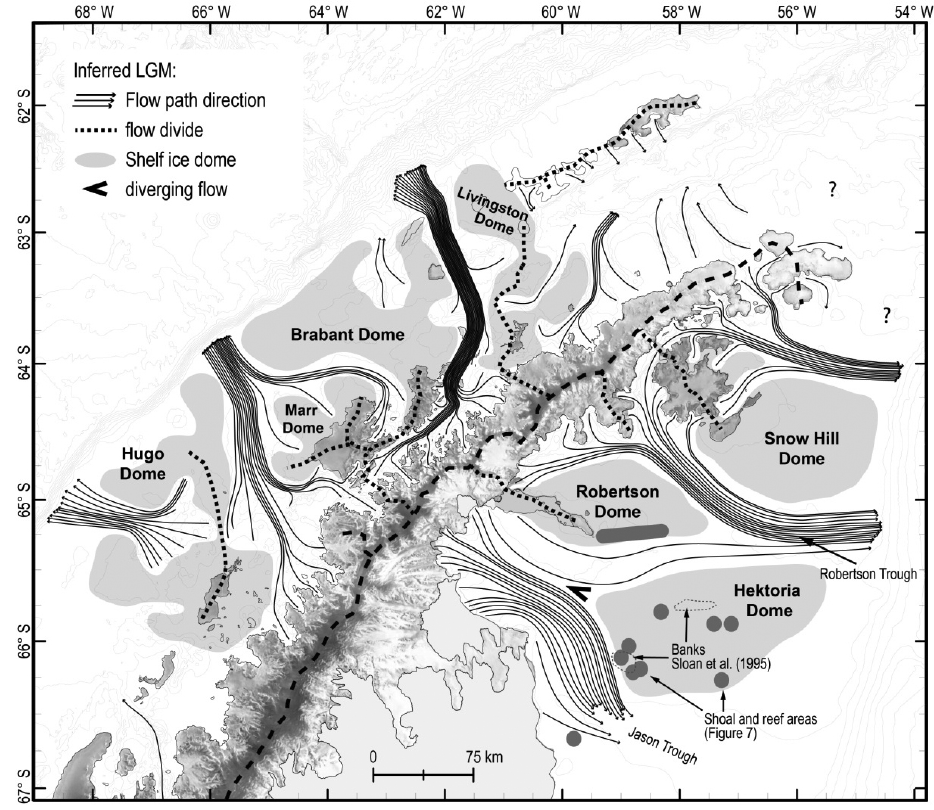
Figure 5. Inferred paleo-ice-flow directions and continental-shelf ice domes around the northern AP continental shelf at LGM showing ice divides (black short-dashed lines), shelf ice domes (gray areas), and the bifurcating flow in the Larsen B embayment. The modern divide along the AP (black dash line) is probably not at the same location of the LGM divide, but it is close. Also identified are the topographic banks by Sloan et al. (1995) and the shoal and reef areas of Fig. 7. The bathymetry contour interval of 250m is from IBCSO (Arndt et al.,